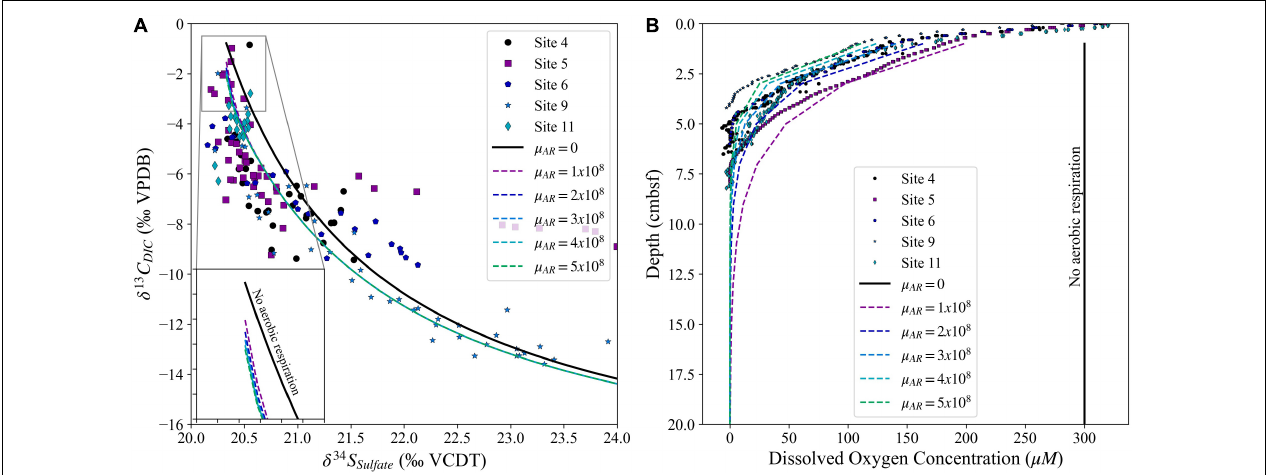
FIGURE 6 | Panel (A) displays the change in sulfur isotopic composition of sulfate vs. the change in carbon isotopic composition of the DIC, while panel (B) displays the measured dissolved oxygen concentrations over the upper 20 cm of the five sites. In both panels the lines represent model runs for varying rates of aerobic respiration, with a constant rate of sulfate reduction, ranging from no aerobic respiration (black solid line) to aerobic respiration depleting the oxygen in the upper 5 cmbsf (green dashed line).